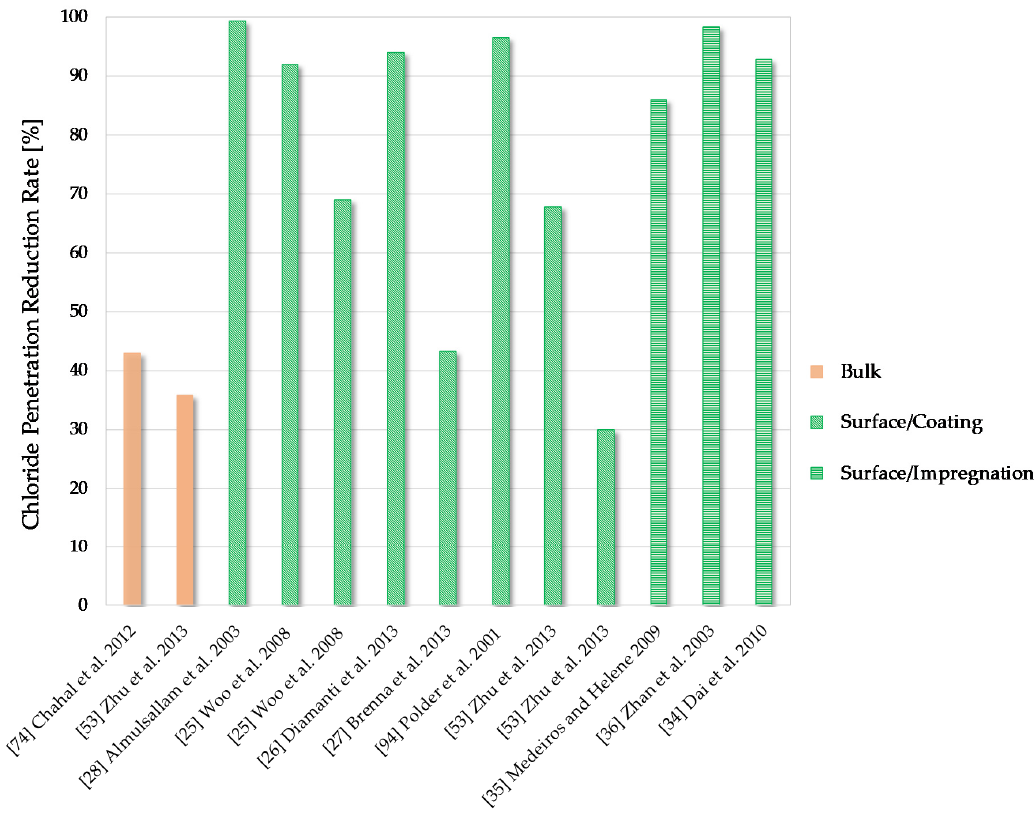
Figure 21. Review on chloride penetration reduction rate reported in the literature about hydrophobic modifications on concrete.